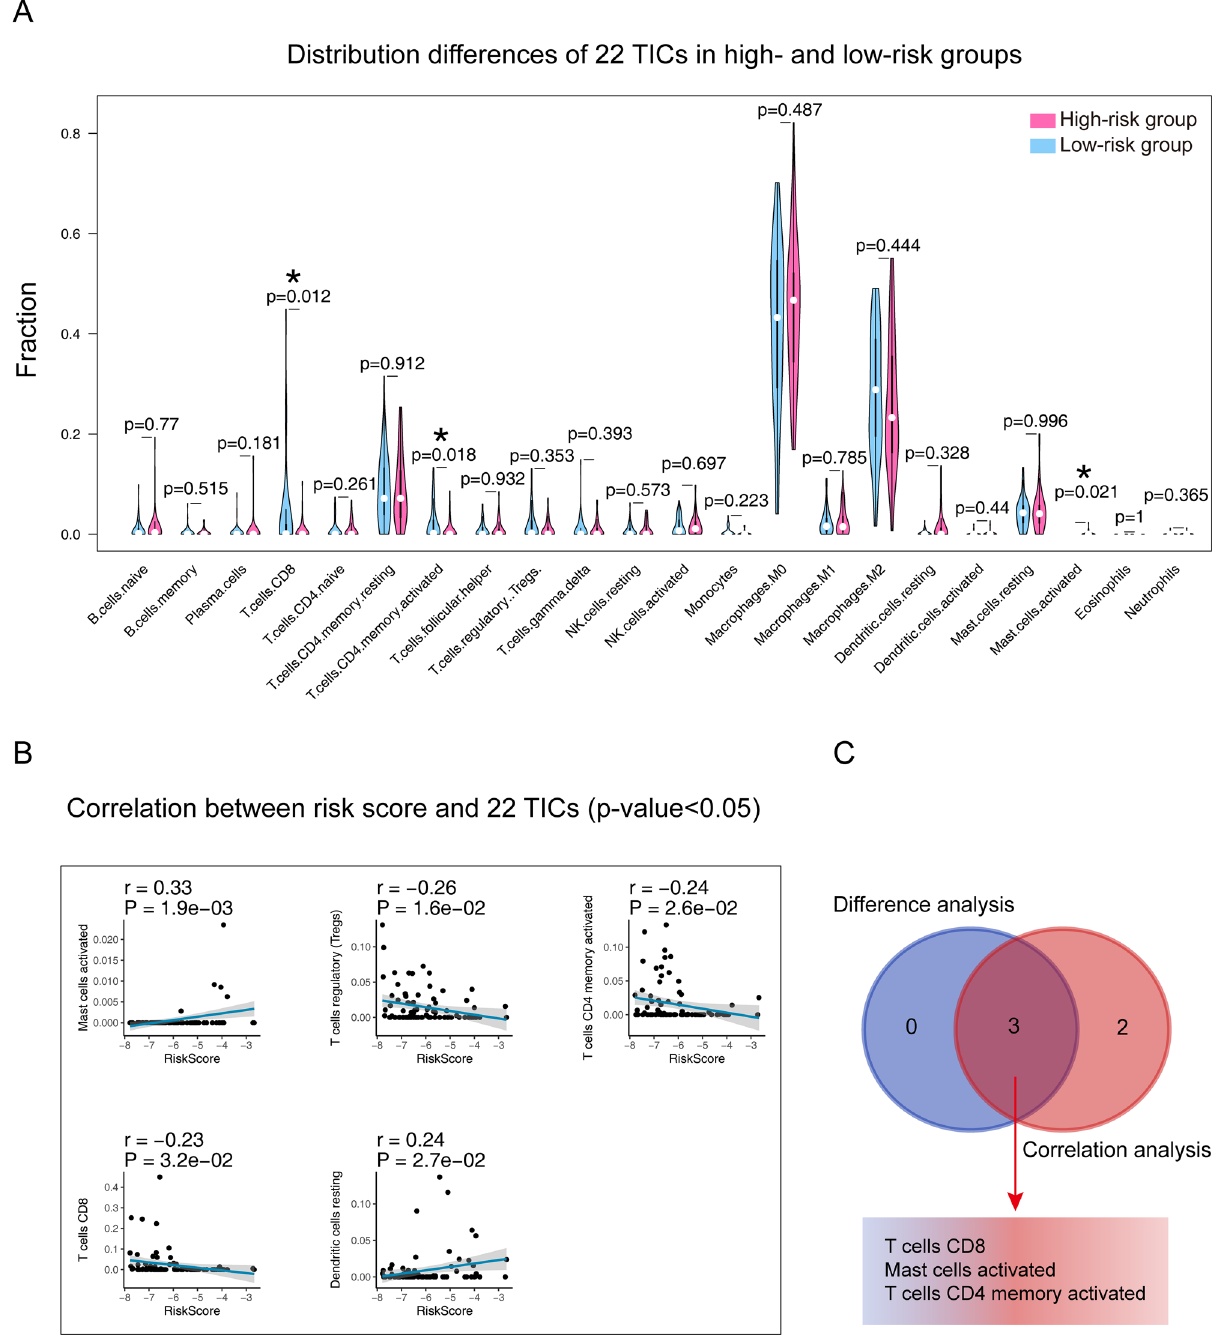
Figure 10. Integrating analysis for the relationship between TICs and the seventeen-gene signature. ( A ) Wilcoxon rank-sum was adopted to differentiate each of 22 TICs between the high- and low-risk groups. ( B ) The Pearson coefficient was applied for the correlation test between the TICs and the seventeen-gene signature. Only correlations with p value < 0.05 were plotted. ( C ) The Venn diagram that integrating the results from ( A ) and ( B ). TIC: tumor-infiltrating immune cell; *p value < 0.05; p value < 0.05 was considered statistically